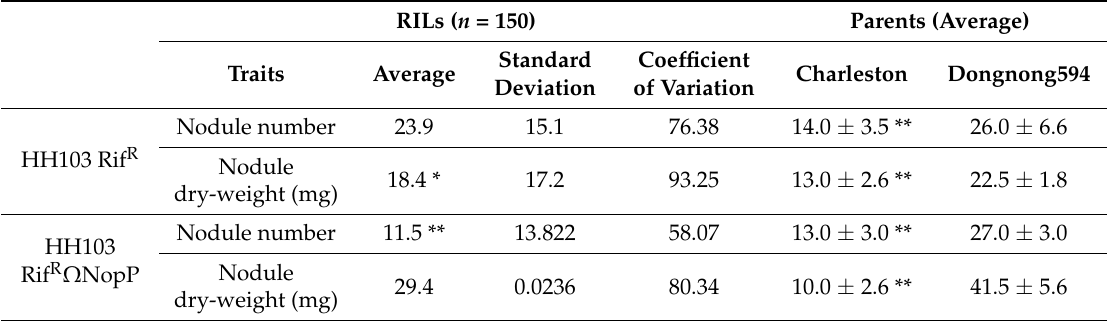
Parental and population statistics for nodule traits in the soybean ‘Charleston’ × ‘Dongnong594’